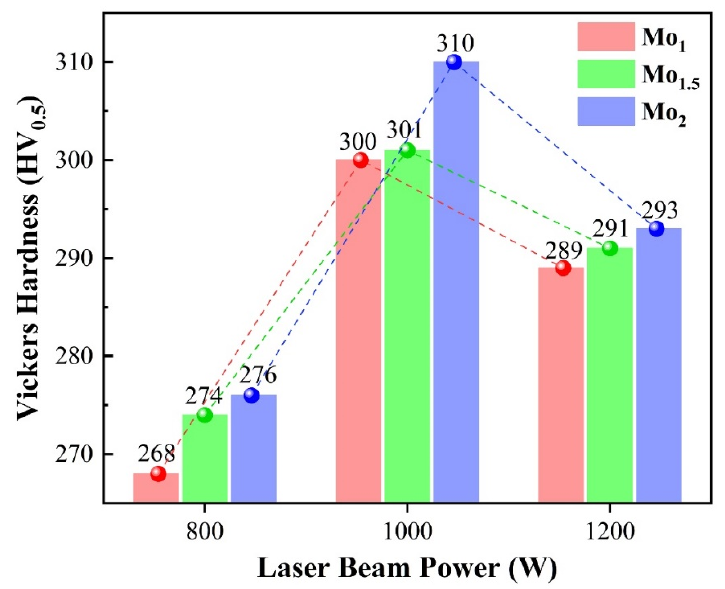
Figure 8. Microhardness of the ((CoCrFeNi) 95 Nb 5 ) 100-x Mo x (x = 1, 1.5, 2) HEA coating.